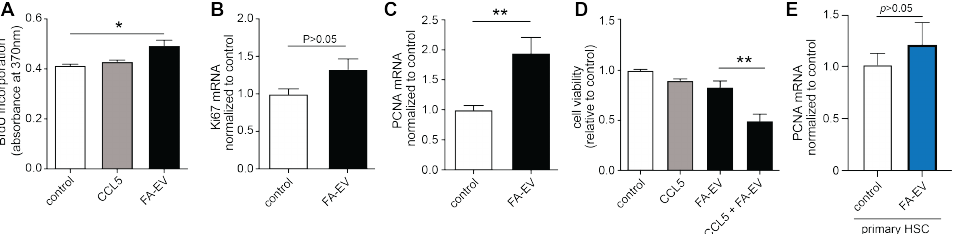
Figure 3. Proliferation and cell viability of TWNT4 cells and primary HSC after EV treatment. Proliferation of TWNT4 cells measured by BrdU incorporation after treatment with CCL5 or FA-EVs ( A ). Expression of the proliferation markers Ki67 ( B ) and PCNA ( C ) after treatment of TWNT4 with FA-EV. ( D ) Viability of TWNT4 cells after treatment with CCL5, FA-EVs, or a combination of CCL5 and FA-EVs. ( E ) Primary HSCs were treated with or without FA-EVs, and mRNA expression levels of PCNA were measured. * p < 0.05, ** p < 0.01 with post hoc ANOVA and Bonferroni test or 2-tailed t -test; mean ± SEM (n =